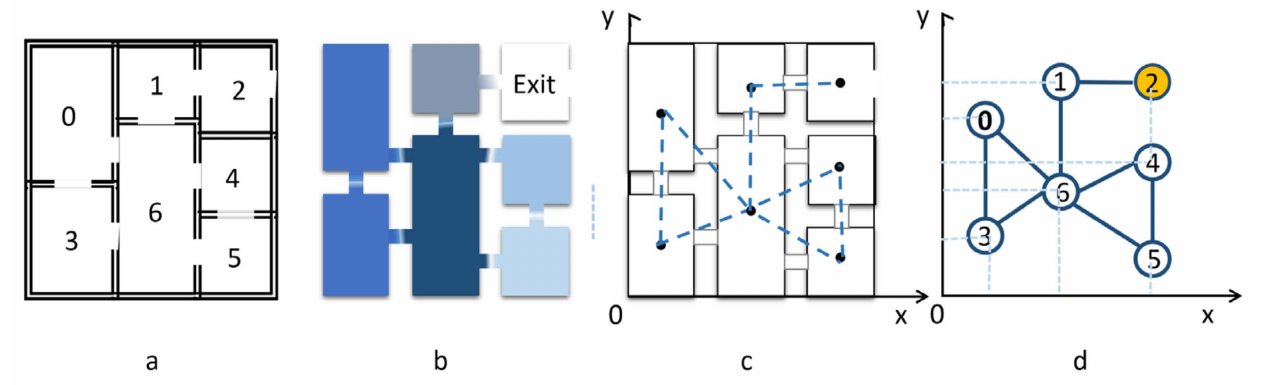
Figure 1. Evacuation network abstraction. ( a ) Evacuation scenario. ( b ) Subspaces and their connec- tions. ( c ) Center point of subspaces and their adjacen edges. ( d ) Final evacuation network.